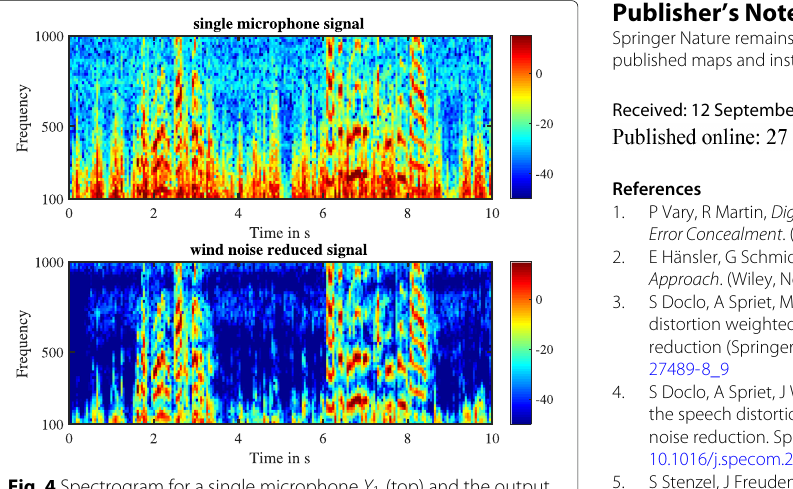
Fig. 4 Spectrogram for a single microphone Y 1 (top) and the output signal Z from (46) (bottom) in a wind noise only